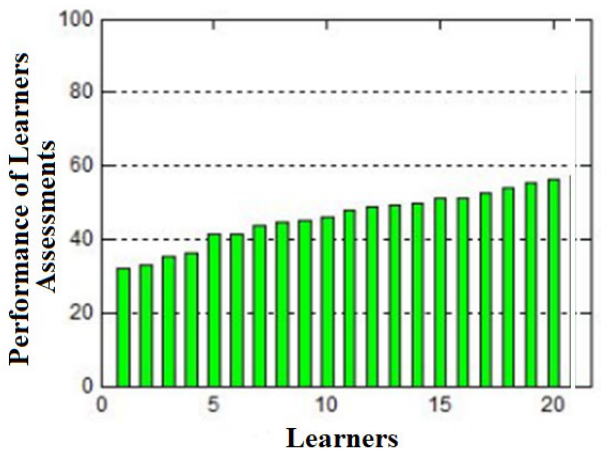
Figure 11. Performance of the learners The iOBE 5.2 software run on MATLAB compiler, and it computes the learning objectives for each course and plotted the graphs. The corresponding CO and PO’s are mapping to the percentage of CO-PO attainment as shown in Figure